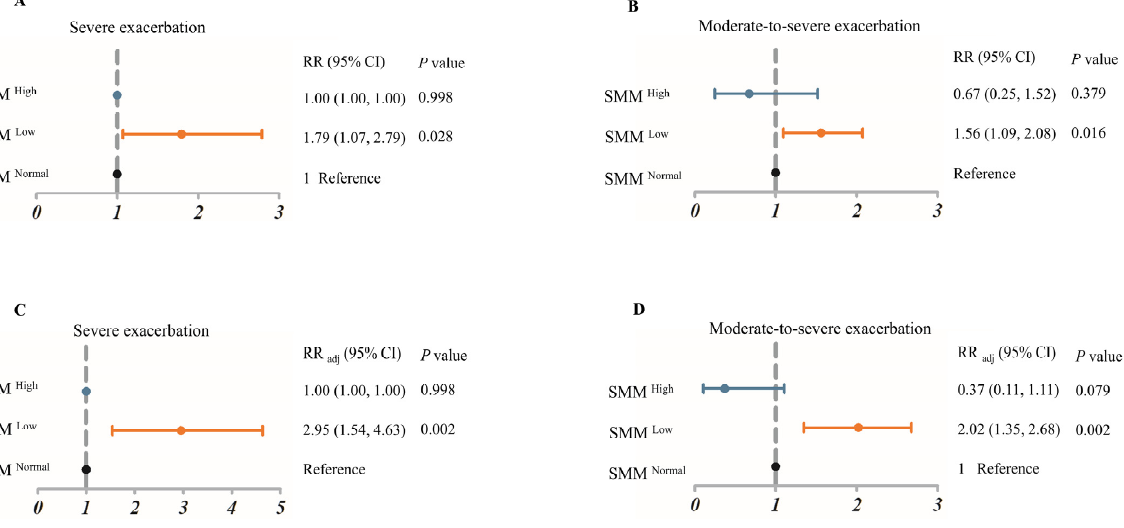
Figure 2. Associations of the SMM (skeletal muscle mass) with ( A ) severe exacerbation; univariate logistic regression analysis, ( B ) moderate-to-severe exacerbation, univariate logistic regression analysis. ( C ) severe exacerbation; multiple logistic regression analysis. Adjusted for age, sex, BMI, smoking status, ICS/LABA, cumulative doses of OCS equivalent to prednisone, severe exacerbation in the past year, pre-bronchodilator forced expiratory volume in 1 s% predicted ( D ) moderate-to-severe exacerbation, multiple logistic regression analysis, with normal SMM as the reference. Adjusted for age, sex, BMI, smoking status, ICS/LABA, cumulative doses of OCS equivalent to prednisone, severe exacerbation in the past year, pre-bronchodilator forced expiratory volume in 1 s% predicted. CI, confidence interval; RR, relative risk; RR adj , adjusted relative risk. Blue, SMM High ; Orange, SMM Low ; Black, SMM Normal .